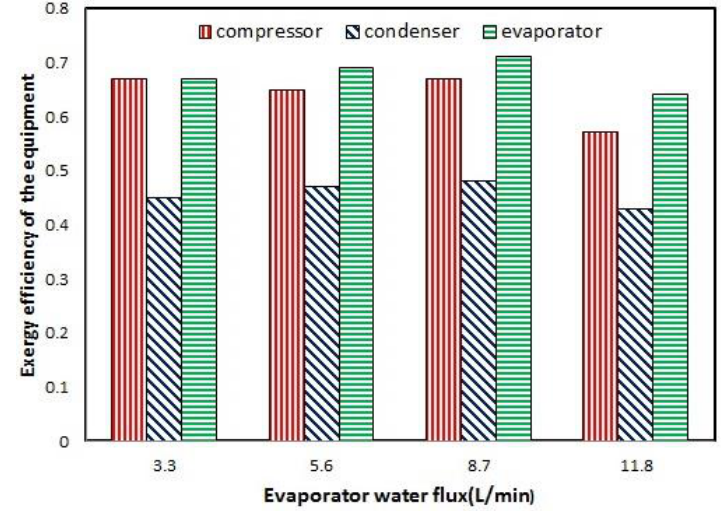
Figure 14. Exergy efficiencies of main components.